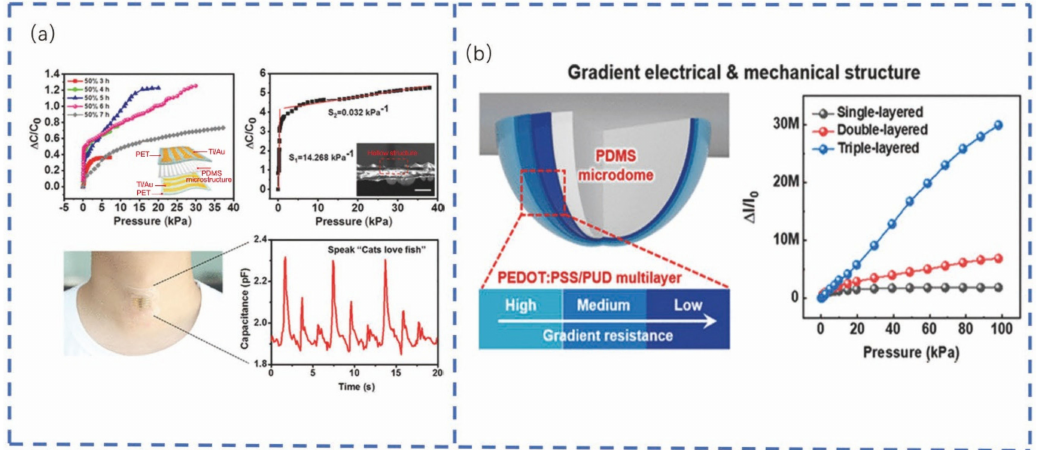
Figure 10. Application of flexible sensors on e-skin: ( a ) a schematic diagram of a flexible pressure sensor based on a wrinkled microstructure with relative capacitance change as a function of the pres- sure, mounted on a human throat for vocal recognition tests [171]; ( b ) a multilayer PEDOT:PSS/PUD located on the top of a micro-dome pattern PDMS layer with different layers of pressure-related relative current changes in a multilayered electronic skin